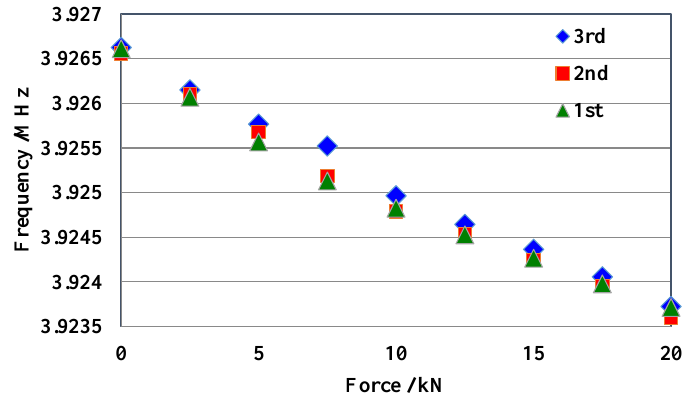
Figure 5. Conductance frequency changes of M16 bolt under different forces.